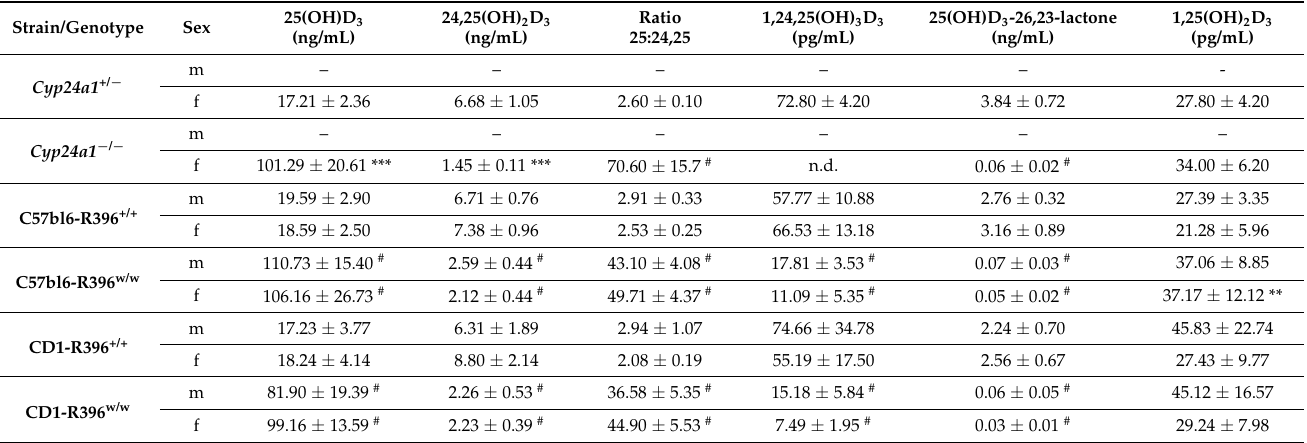
Table 1. Vitamin D metabolites in preclinical models of infantile hypercalcemia type 1.